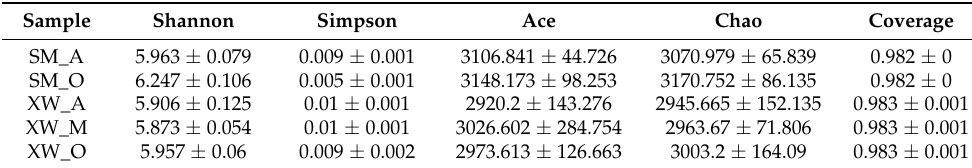
Table 2. Alpha diversity indices (bacterial richness and diversity) of the microbial communities found in the wastewater treatment plants.